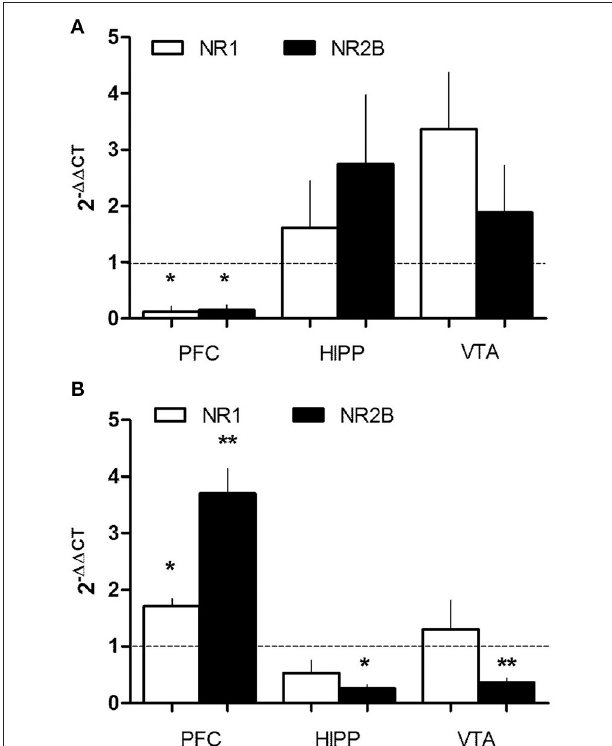
FIGURE 4 | PEE modifies NMDAR mRNA expression in rat brains. Total RNA was obtained from the Prefrontal cortex, (PFC), Hippocampus (HIPP), and Ventral tegmental area (VTA) from Control or PEE rats of 21 (P21) (A) or 70 (P70) (B) days old. RT-qPCR was performed using specific primers for NMDAR mRNA subunits (NR1 and NR2B). Data is expressed as a fold of expression in PEE vs. control samples. N = 3–5 litters. * P < 0.05, ** P < 0.01 (paired Student’s t -test compared with 1).